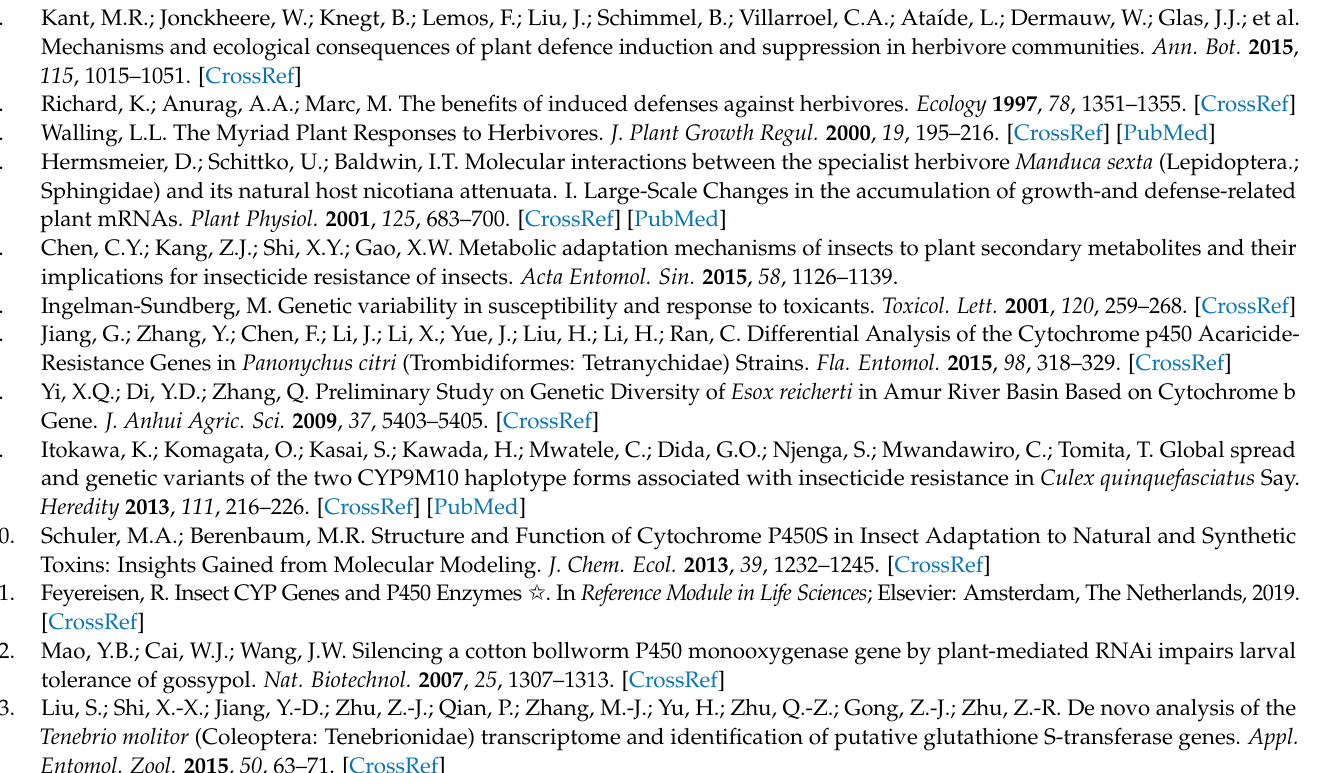
Table S2: Protein sequence of Tomicus